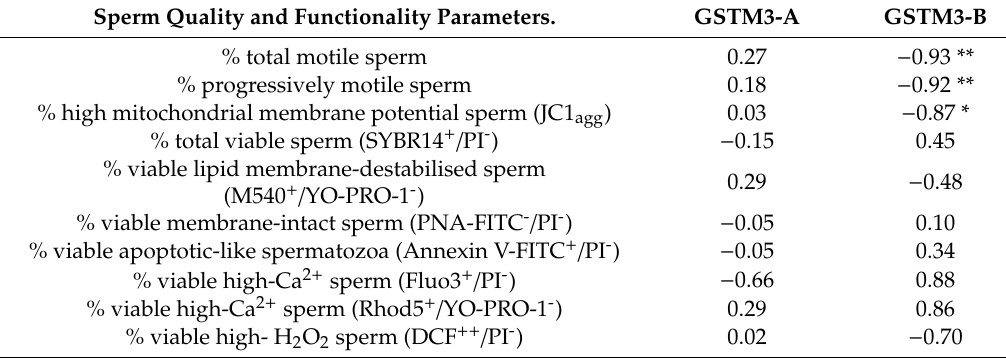
Table 1. Pearson correlation coefficients between the relative GSTM3-A and GSTM3-B abundance at 0 h and sperm quality and functionality parameters at 72 h of liquid storage at 17 °C. Sperm Quality and Functionality Parameters.